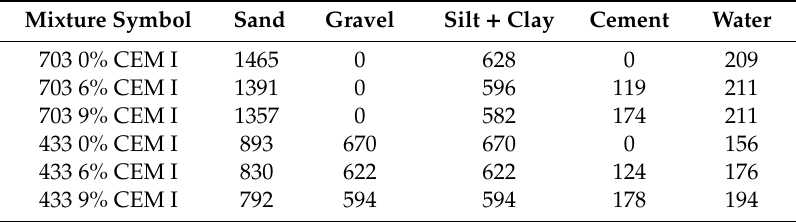
Table 3. Compositions of soil, cement and water mixtures, [kg / m 3